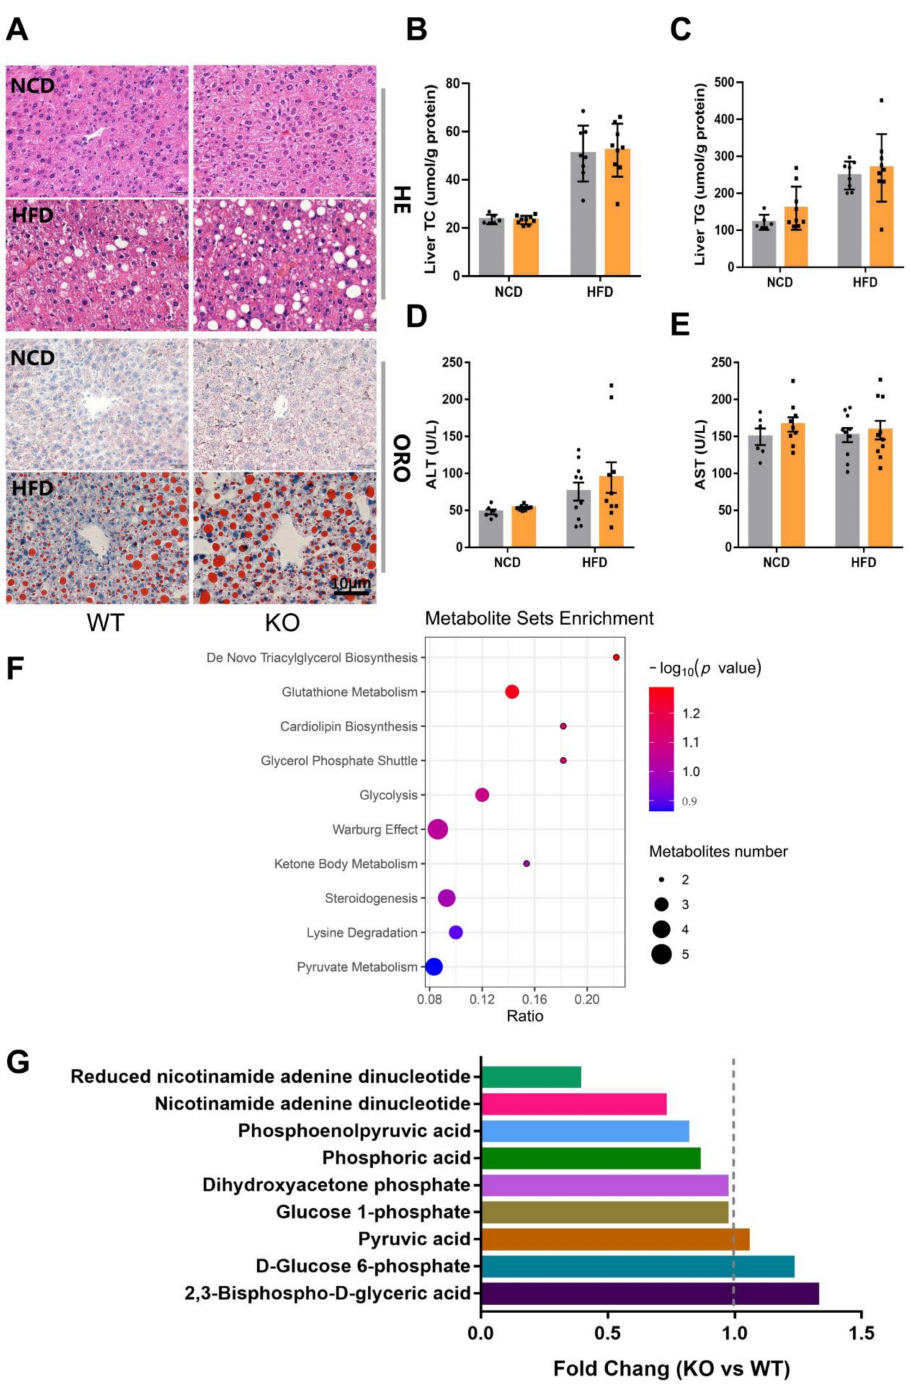
Figure 3. Ablation of miR-23b/27b/24-1 cluster alters glycolysis. ( A ) Representative images of hematoxylin and eosin (H&E)- and Oil-red O (ORO) -stained sections of liver from NCD or HFD-induced WT and KO mice. Scale bar: 10 µ m. ( B ) Levels of hepatic cholesterol and triglycerides ( C ) of WT and KO mice fed an NCD ( n = 6–9) or HFD ( n = 8–9). ( D ) Levels of alanine aminotransferase (ALT) and ( E ) aspartate aminotransferase (AST) of WT and KO mice fed an NCD ( n = 6–9) or HFD ( n = 10). ( F ) Metabolite enrichment analysis revealed the top 10 pathways that were enriched. ( G ) Expression of metabolites involved in glycolysis